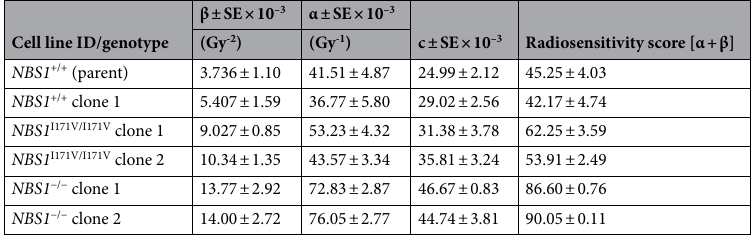
Table 3. Radiosensitivity coefficients (α, β, c, and α + β) in NBS1 I171V variant knock-in HCT116 cells. α, β, and c coefficients were extracted from dose–response calibration curves in the CBMN assay using Cabas software. Relative capacity to repair DNA after acute γ-irradiation was assessed at a dose of 1 Gy.